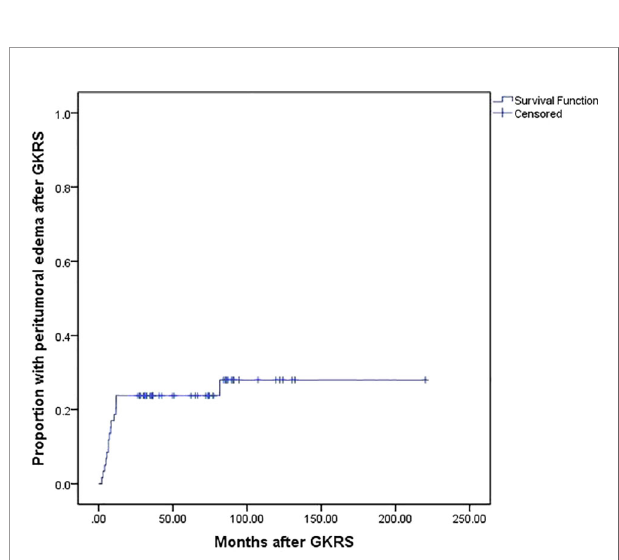
FIGURE 4 | Kaplan-Meier curve of proportion with peritumoral edema after GKRS for the entire